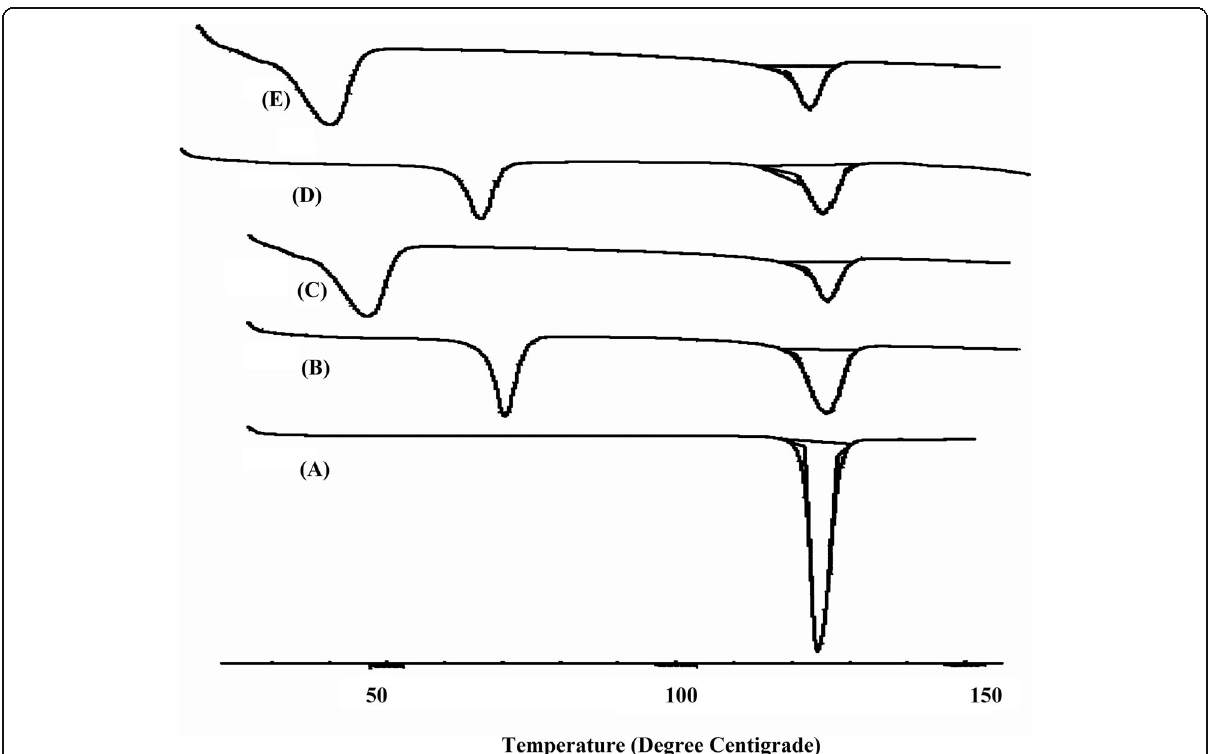
Fig. 1 DSC thermo-gram of a : pure drug Nimodipine, b : solid dispersion of Nimodipine with Compritol ATO 888 (1:1), c : Solid dispersion of Nimodipine with Gelucire 43/01 (1:1), d : Solid dispersion of Nimodipine with Gelucire 39/01(1:1), e : Solid dispersion of Nimodipine with Precirol ATO